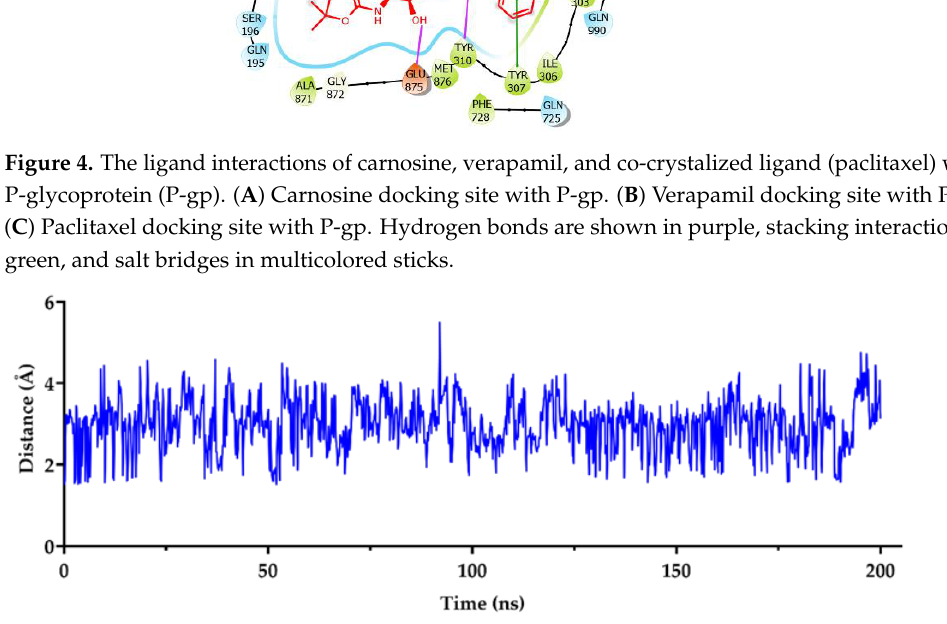
Figure 5. The distance (Å ) of the bonding interactions of carnosine with P-glycoprotein GLU875. Table 3. Summary of distance statistics of the binding of carnosine with P-glycoprotein GLU875. Minimum